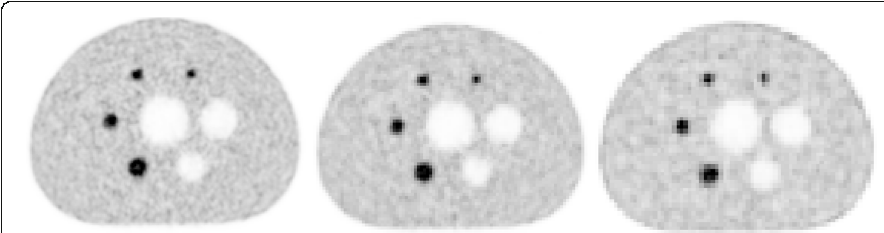
Fig. 6 Reconstructed images of the IEC phantom with the same image roughness (IR = 0.15). The reference was for the mCT using 3 iterations, 21 subsets, no post-filtering, 200 × 200 matrix size, and 3.2 × 10 7 net trues (equivalent to a time acquisition of 120s). Left: Vision using 4 iterations, 5 subsets, no post-filtering, 440 × 440 matrix size, and 2.4 × 10 7 net trues (reduction factor = 1.34, time acquisition = 89s); middle: Vision using 4 iterations, 5 subsets, no post-filtering, 220 × 220 matrix size, and 1.7 × 10 7 net trues (reduction factor = 1.89, time acquisition = 63s); right: mCT (reference). Gray scale level is identical for all images. Contrast improvement for the different spheres, as compared to the reference, is listed in Tables 4 and 5.